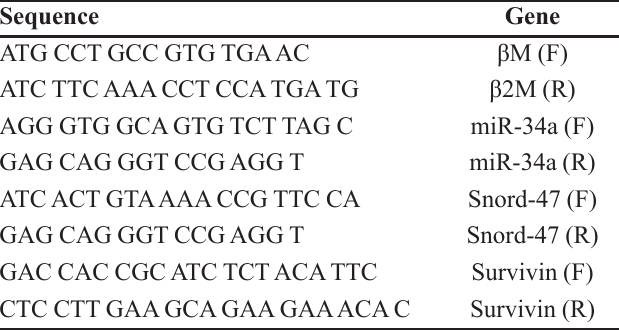
TABLE I - The primer sequences for QRT-PCR Sequence